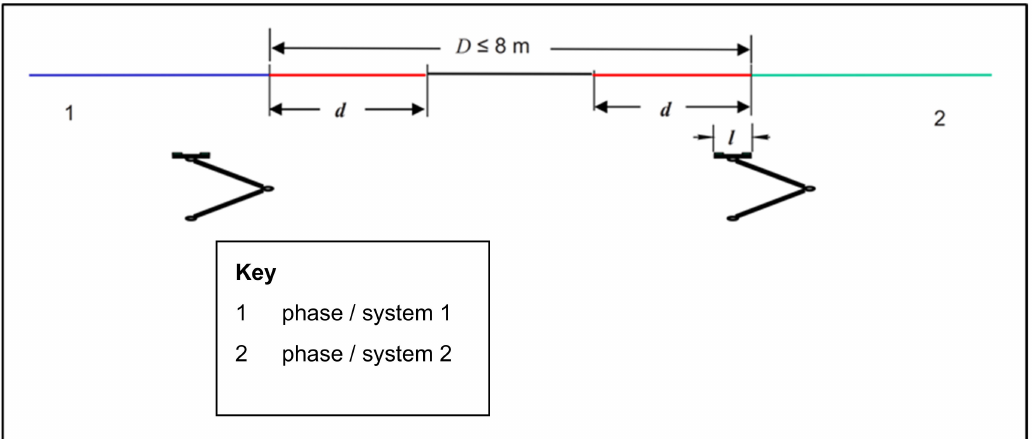
Figure 3. Short neutral section schematic taken from BS EN 50367